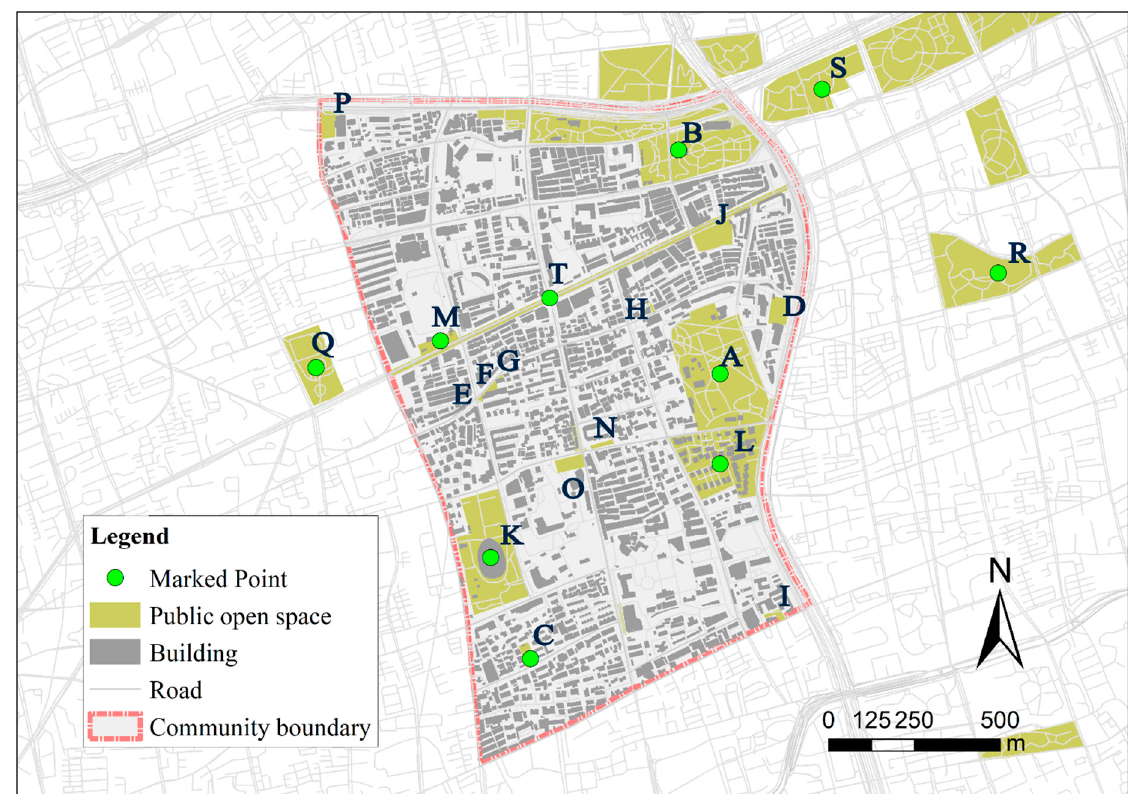
Figure 2. Map of POSs in the 15-min life circle of Ruijin community.